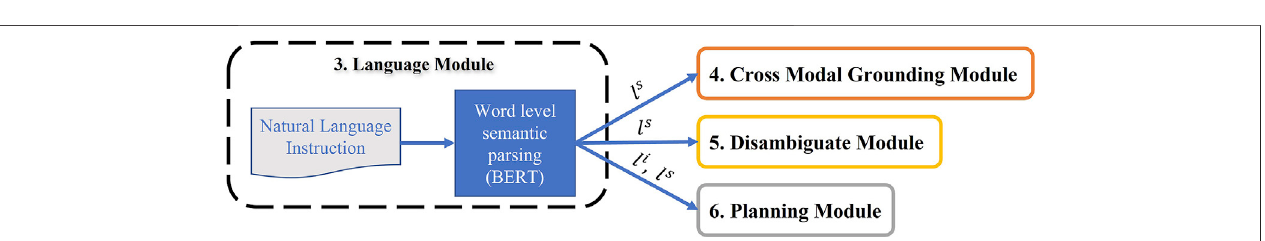
Frontiers in Robotics and AI |